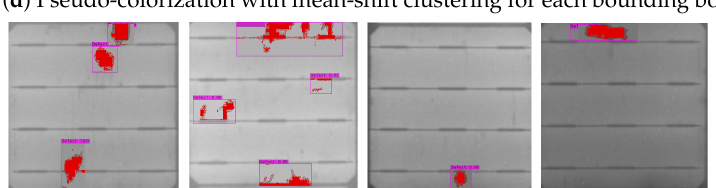
Figure 20. Comparisons of results of different pseudo-colorization techniques applied to ( a ) cell images with detected bounding boxes of defects. The colorization results of conventional image processing methods of the Otsu binarization on cells and of the Canny edge detection on bounding boxes are shown in ( b , c ), respectively. The clustering and coloring results on bounding boxes using k-means and man-shift clustering techniques are given in ( d , e ),